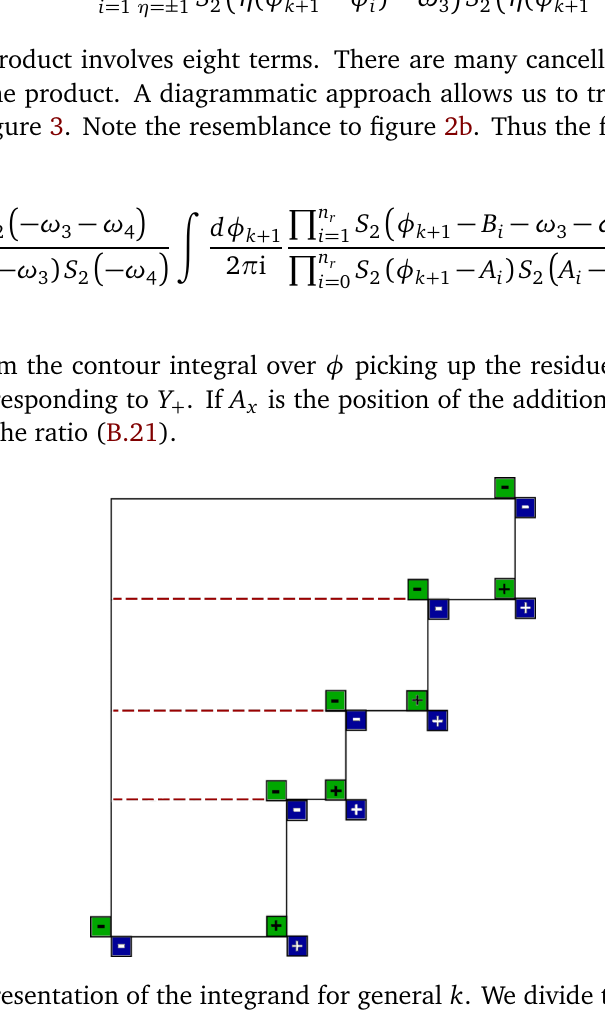
+ ω . 3 4 − ω . We highlight in blue 3 4 k + 1